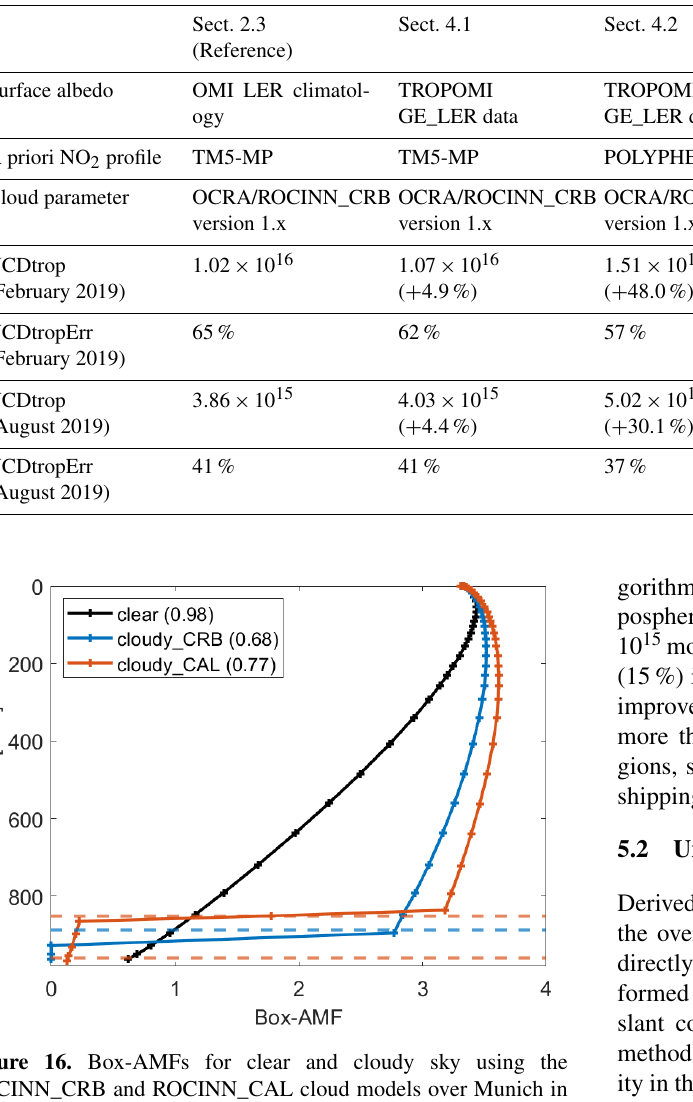
Table 3. Main settings for the step-by-step improvements and results of the tropospheric NO 2 retrievals for the different steps of the updates for Munich (48.15 ◦ N, 11.57 ◦ E). The tropospheric NO 2 columns (VCDtrop) are given in absolute values (molec./cm 2 ), and the percentage numbers in brackets are changes relative to the reference case. The uncertainties in the tropospheric NO 2 columns (VCDtropErr) are given in relative numbers.